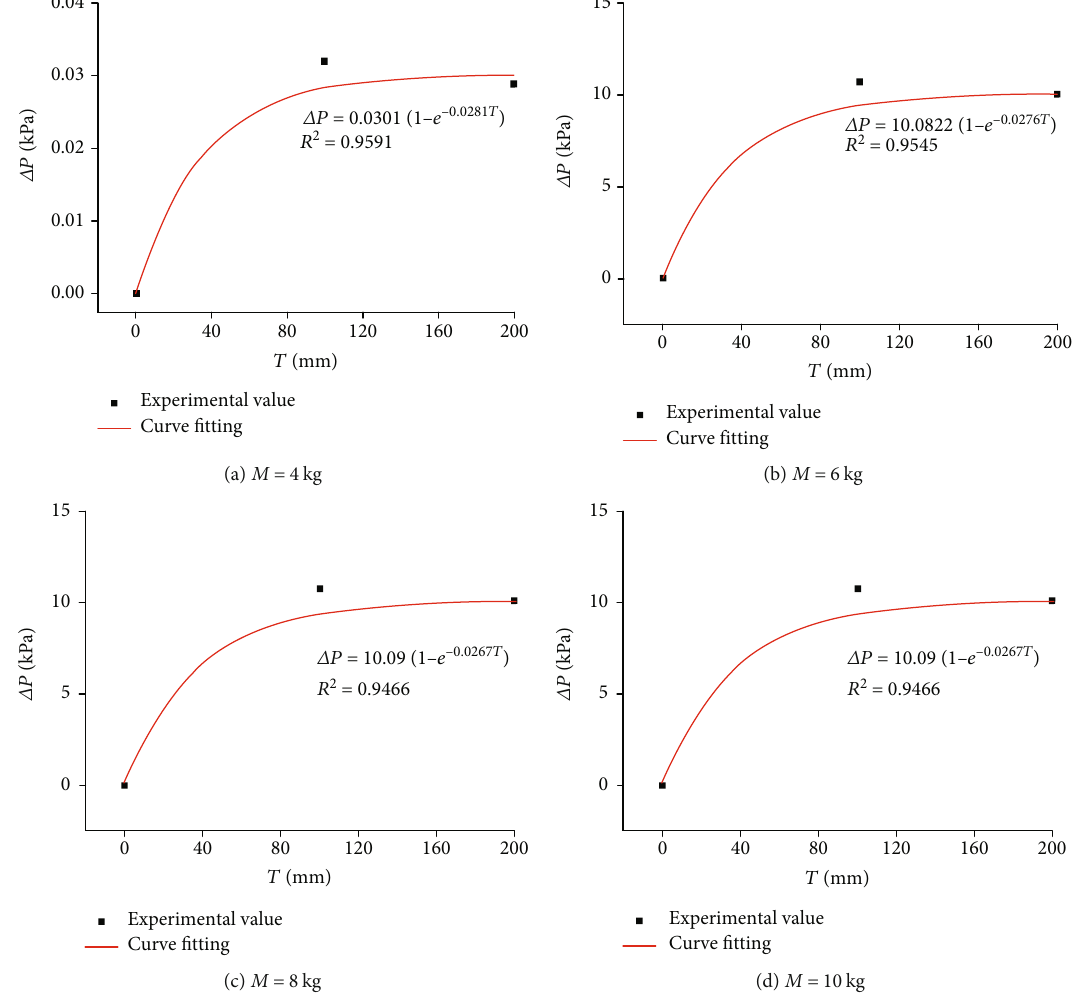
Figure 7: Relationship between pore water di ff erence Δ P and distance T ð F = 2 B Þ